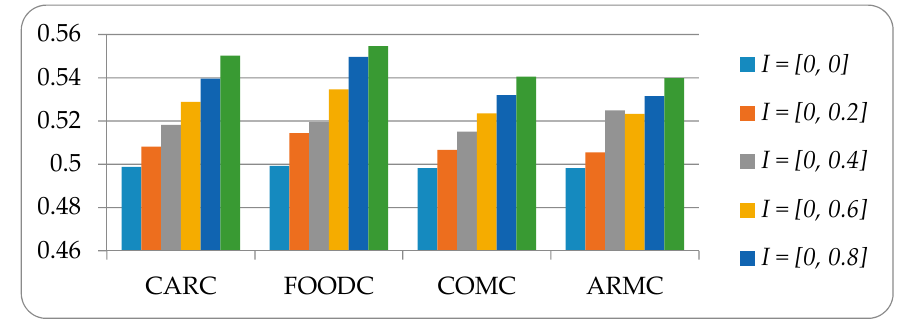
Figure 3. Ranking order with variation of ‘ I ’ based on strategy 1.